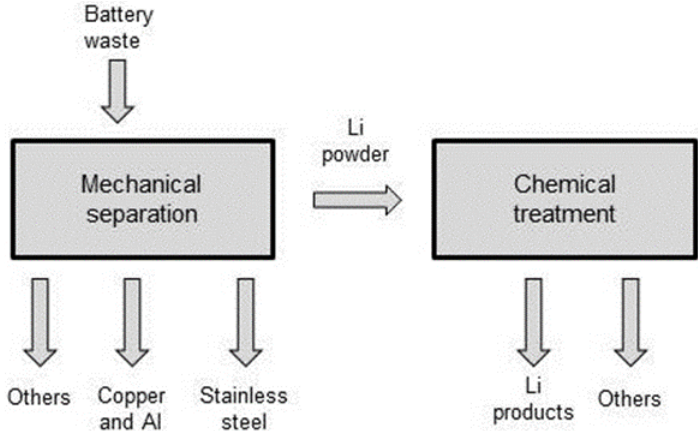
Figure 2. Hydrometallurgical recycling process.